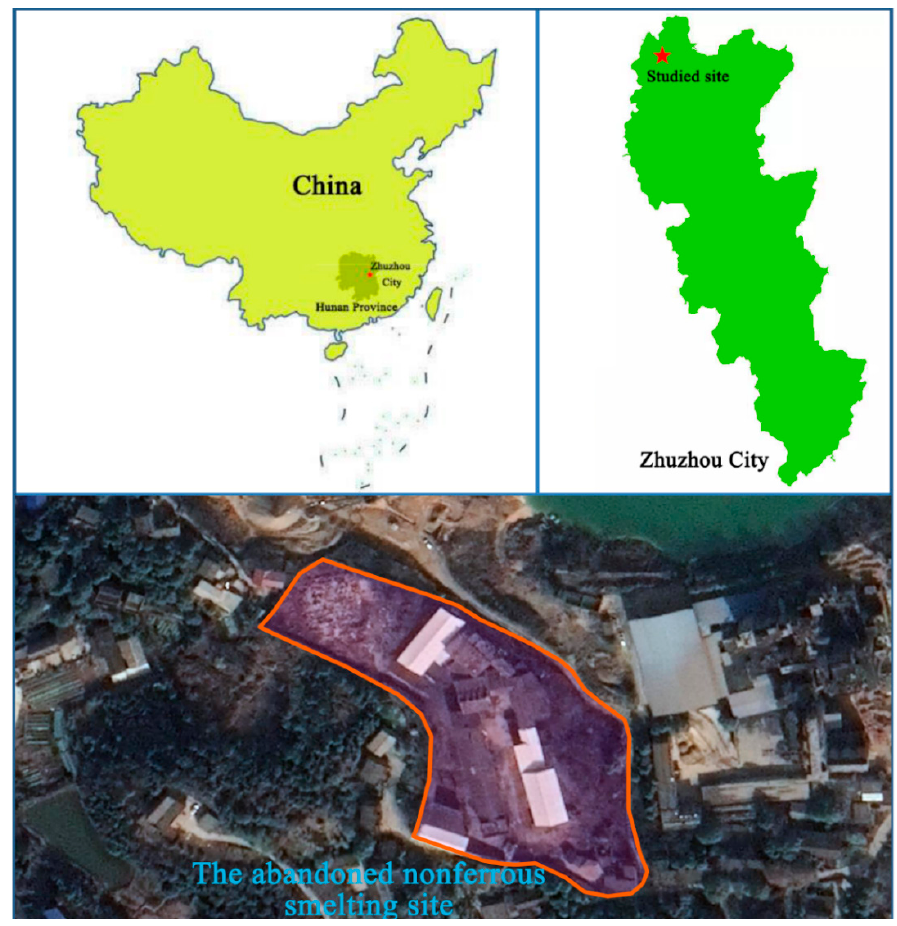
Figure 1. Location of the studied site.